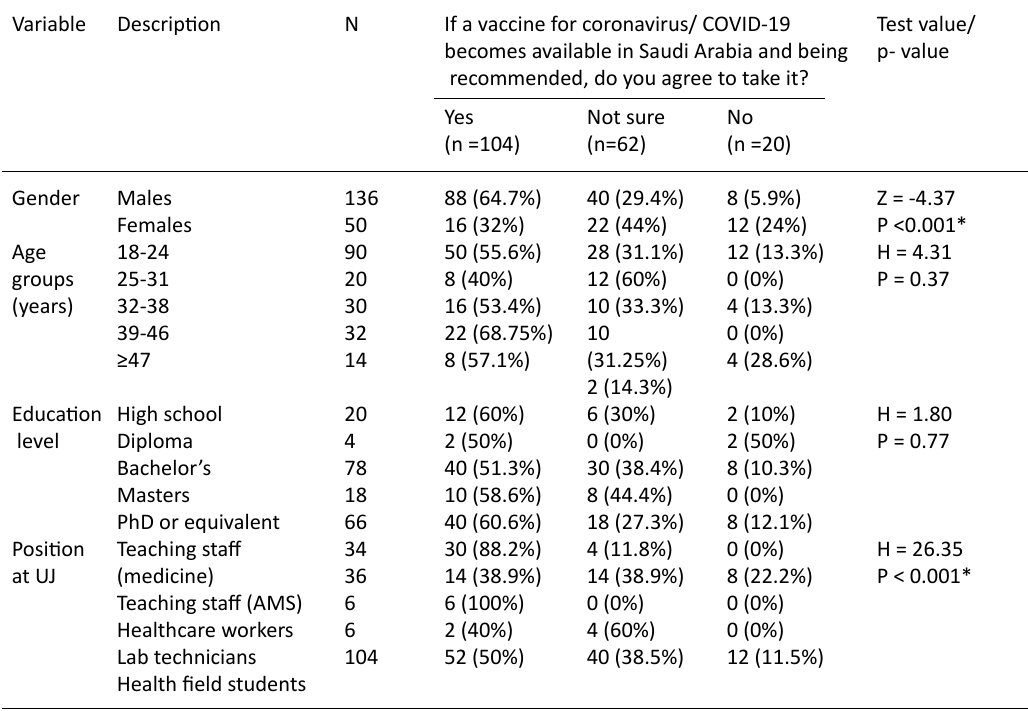
Table 4. Responses of vaccine acceptance across demographic characteristics of participants